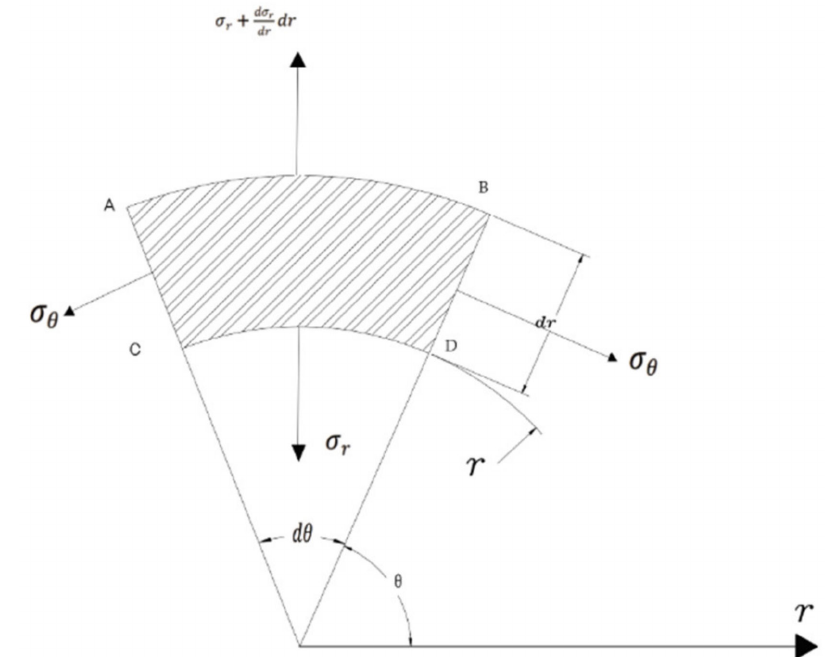
Figure 4. Two-dimensional microelement surface of thick-walled